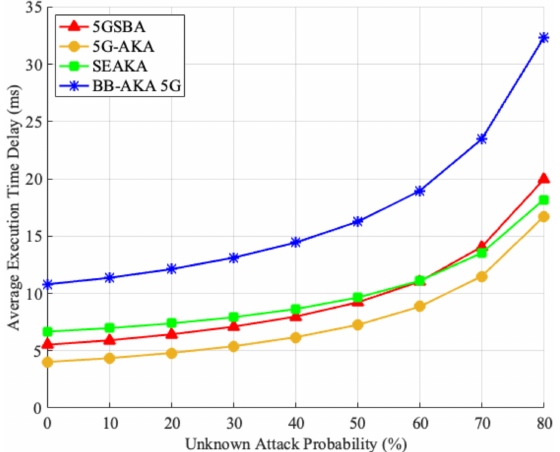
Figure 6. Average delays under unknown attacks.